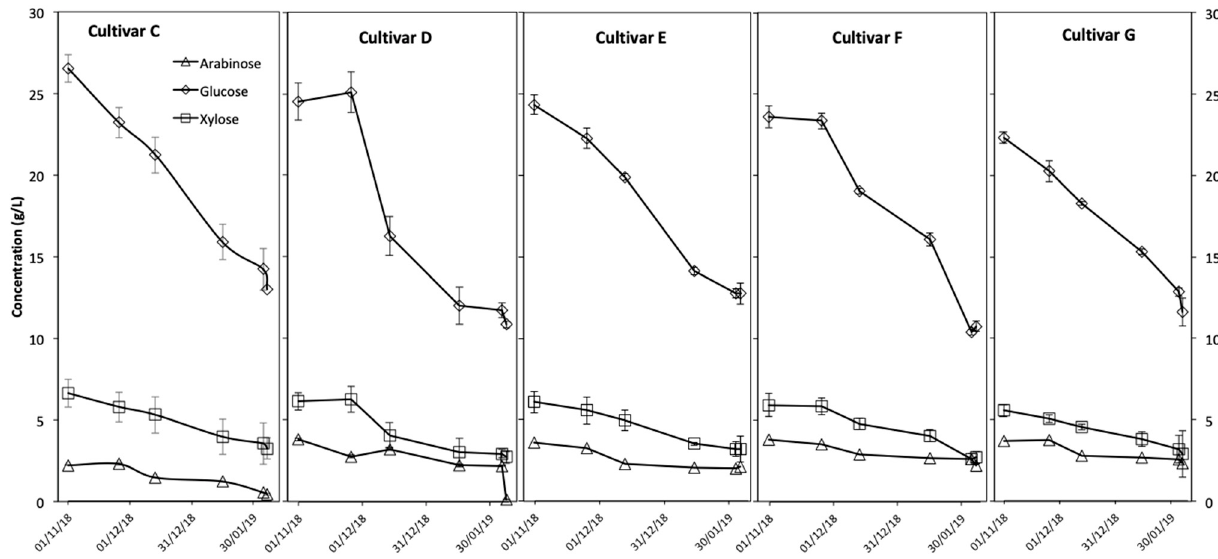
Figure 4. Sugar profiles of the hydrolysate of various Miscanthus cultivars harvested at specific time-points. Data repre- sentative of triplicate values. Harvest dates are 1 November 2018, 20 November 2018, 14 December 2018, 16 January 2019, 5 February 2019 and 7 February 2019. Table 3. Lignin content of Miscanthus Cultivars